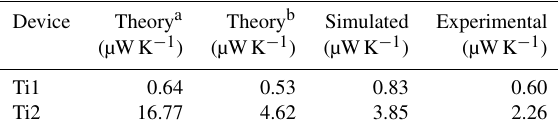
Table 4. A comparison of the thermal beam conductance of the Ti thin-film dual-element devices under vacuum conditions.